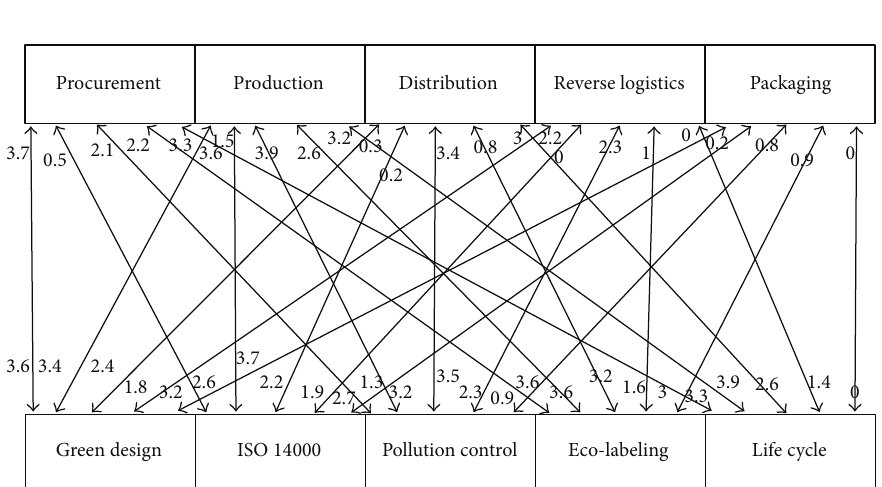
Figure 4: Graphical initial direct impact relation between EP and